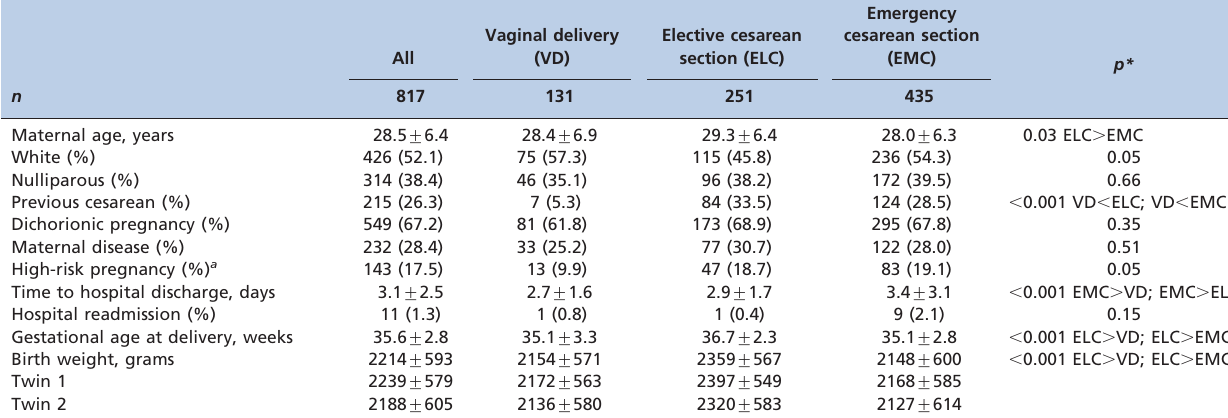
Table 1 - Maternal characteristics and pregnancy information for twin pregnancies according to mode of delivery.